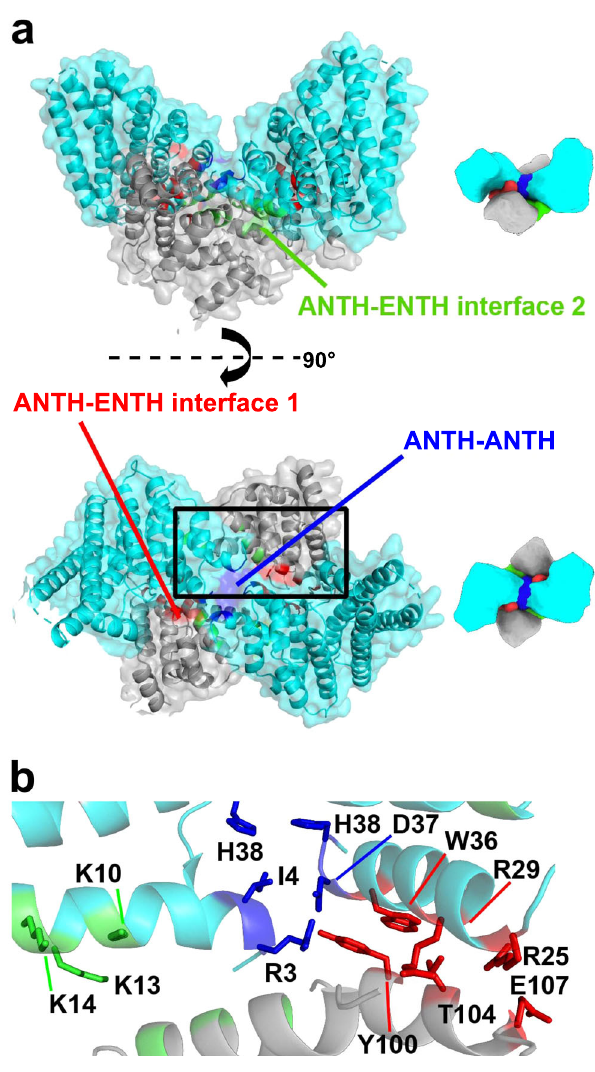
Fig. 3 The AENTH tetramer interfaces. a Surface representation of the A 2 E 2 tetramer, with ANTH subunits in cyan and ENTH subunits in gray. The different interfaces are colored: ANTH-ENTH interface 1 in red, ANTH- ENTH interface 2 in green and ANTH-ANTH interface in blue. b Cartoon representation of the tetramer area within the black rectangle in a showing the different interfacial residues as sticks (same color code as